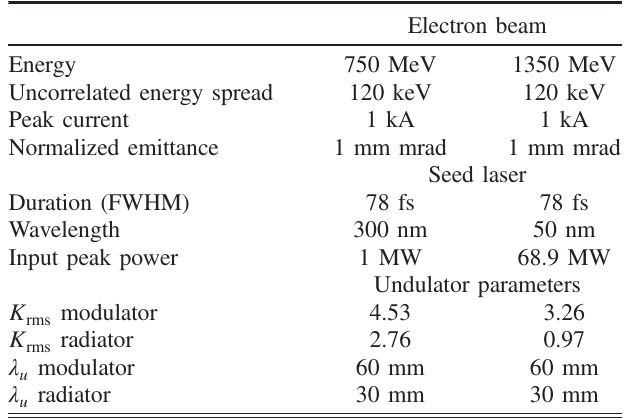
TABLE I. Simulation parameters for the conducted simula-